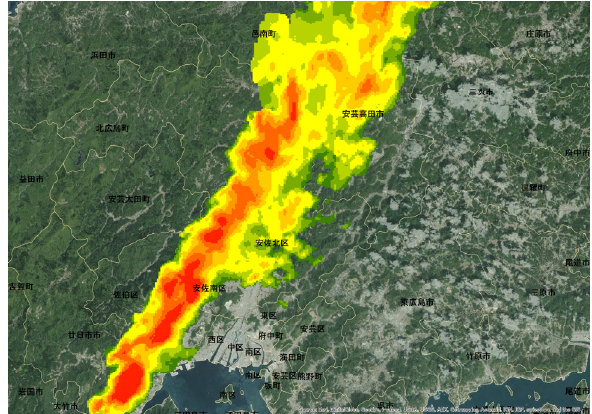
Figure 8. Result of taking rainfall information of the X-band MP radar into GIS (2014.08.20 1:00).